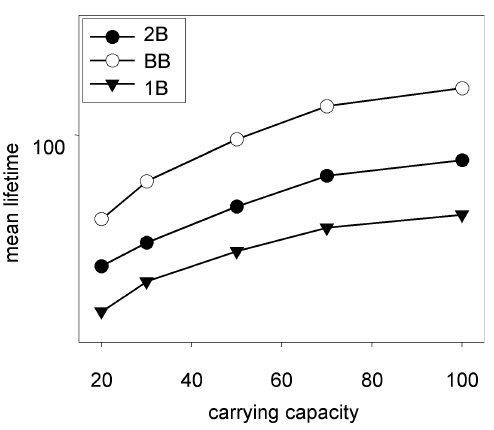
Fig. 4. Mean lifetime vs carrying capacity (adult females) for nat- terjack toad populations with different reproductive strategies. The scenario with three breeding periods corresponds to the BB scenario. 2B has two and 1B has one breeding